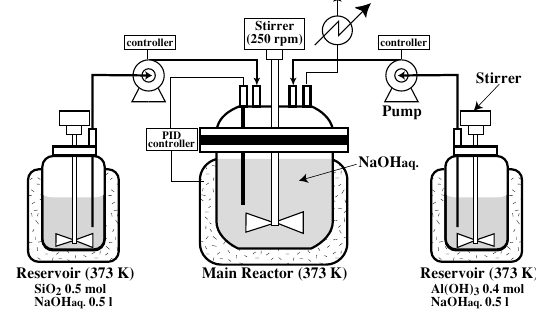
Fig. 7 Experimental set-up for hydrothermal synthesis from pure raw